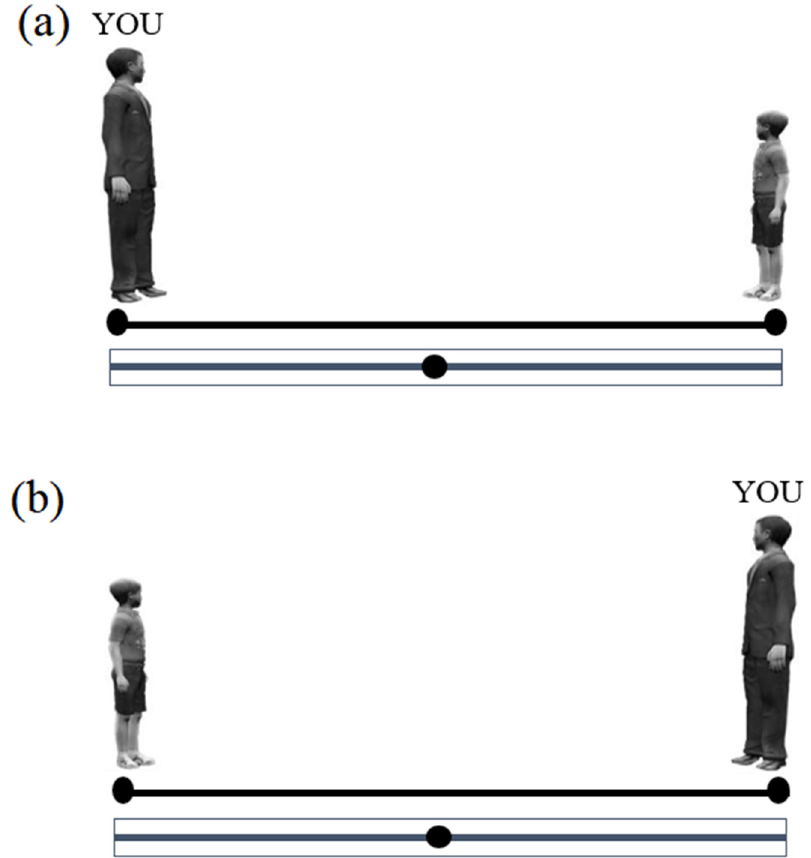
Figure 1. An example of Interpersonal Visual Analogue Scale trials is depicted. The label “YOU” indicates a male participant; the other character on the opposite of the line represents the confederate, i.e., the person with respect to whom the preferred distance is determined (in this case a male child). The preferred distance was to be indicated by moving the slider along the straight gray line: the further the slider was placed from the participant (YOU), the larger the distance from the other person. The character “YOU” could appear in 50% of the trials on the left side ( a ) and on the right side in the other 50% ( b ).